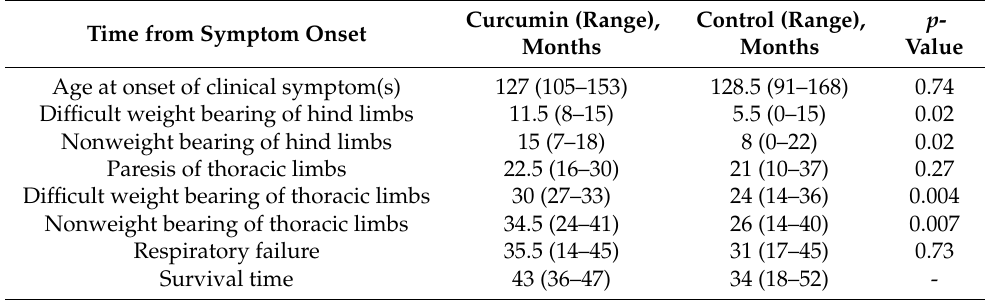
Figure 3. A Kaplan–Meyer survival curve for curcumin-treated and control dogs. Table 2. Comparison of disease progression of degenerative myelopathy between curcumin-treated and control dogs.